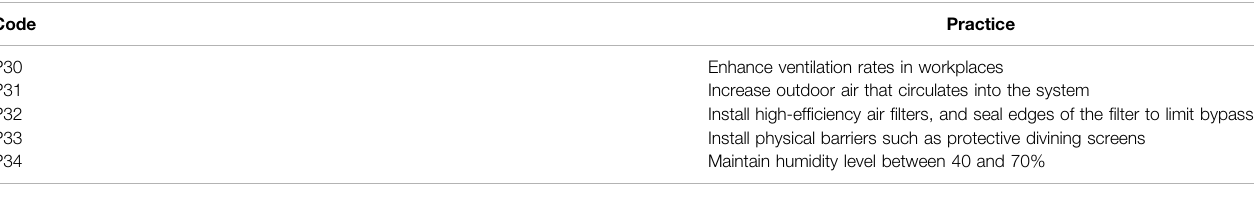
TABLE 7 | Recommended practices to implement engineering controls.